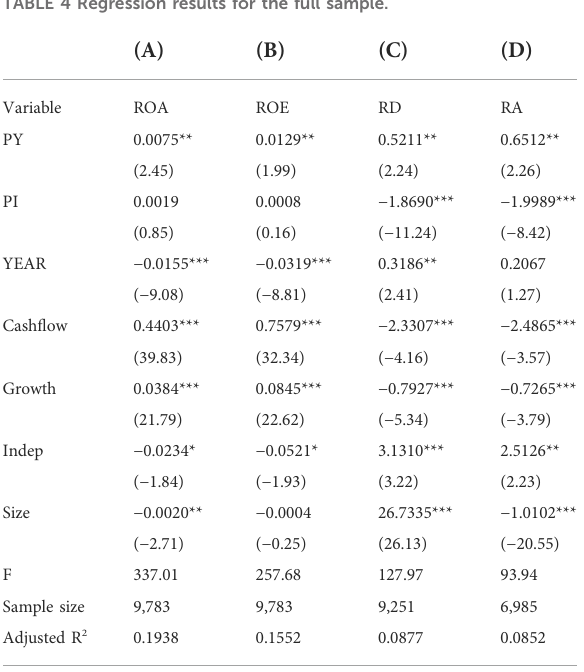
TABLE 4 Regression results for the full